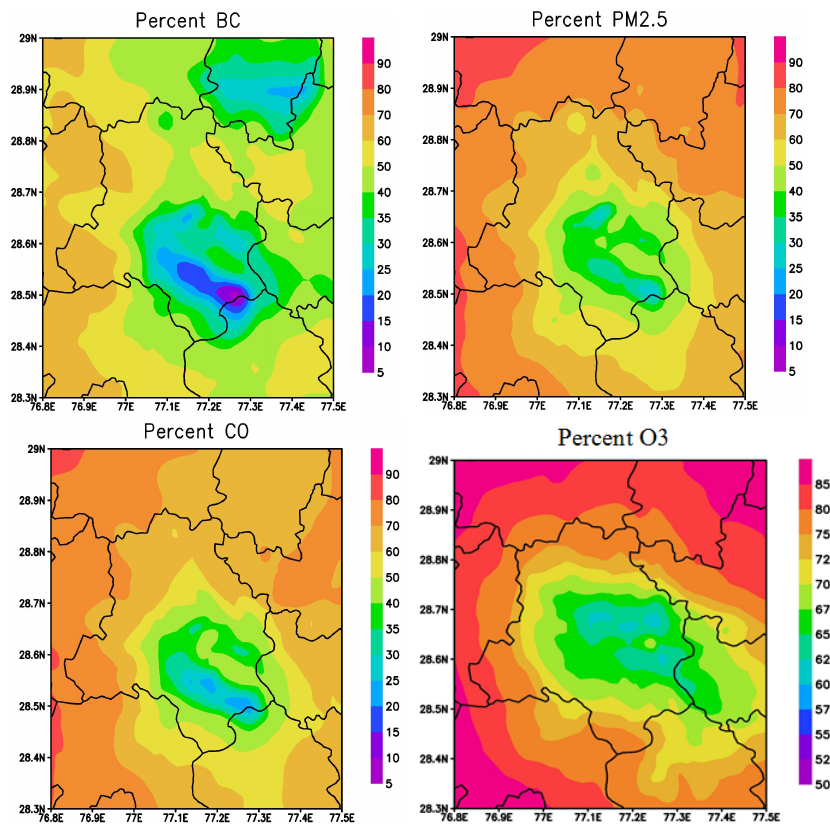
Figure 11. 20 day mean contributions of pollutants from outside